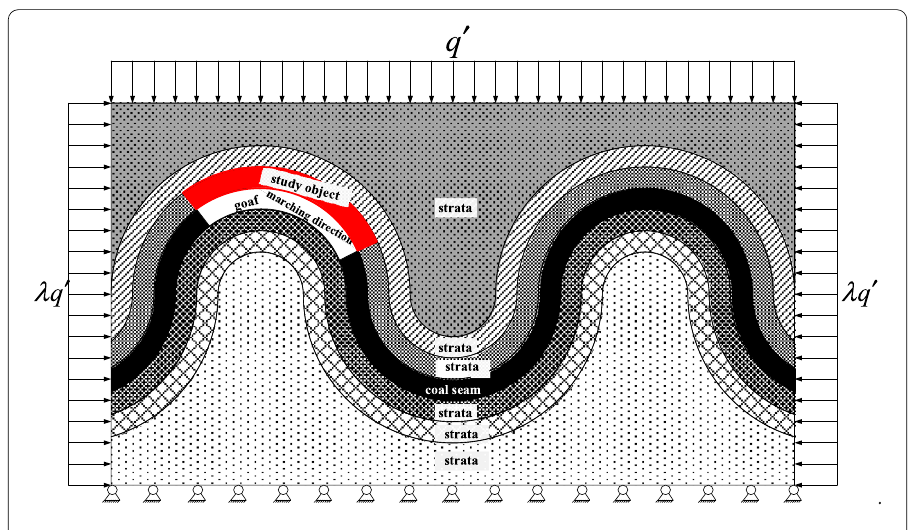
Figure 1 Schematic diagram of coal seam mining in curved rock